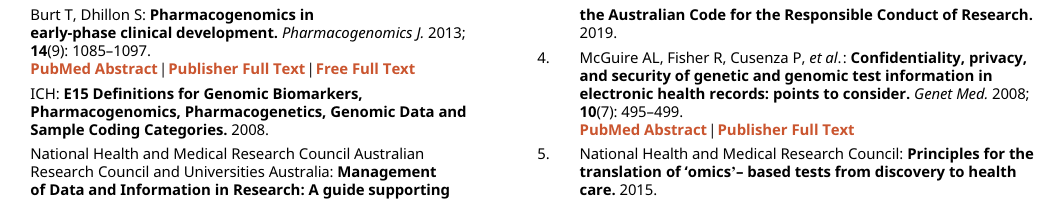
Figshare: Attitudes to genetic testing in phase 1 survey questions. https://doi.org/10.6084/m9.figshare.14182898.v1. 12